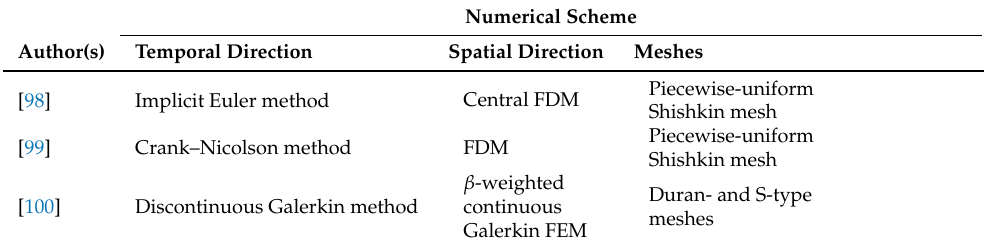
Table 12. Various methods and mesh used to solve Equations (17) and